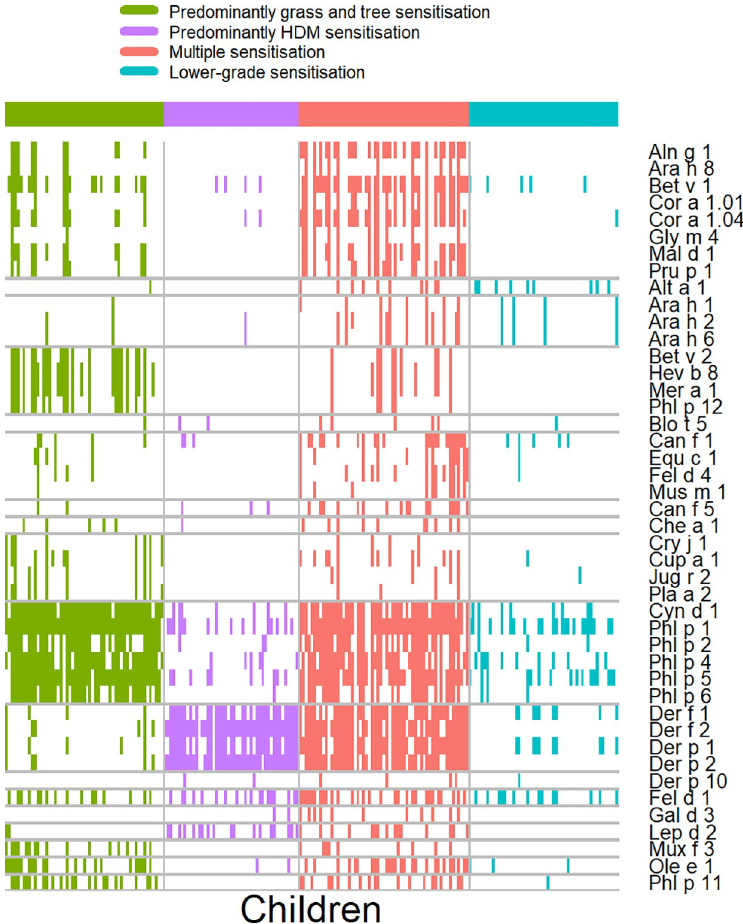
Fig 3. Patterns of IgE responses to allergen components for individual participants. Rows represent sIgEs, while columns indicate children. Colours represent sensitisation clusters’ membership. Squares are coloured if and only if a child has a positive response, < 0.30 to a particular sIgE. IgE, immunoglobulin E; sIgE, specific immunoglobulin